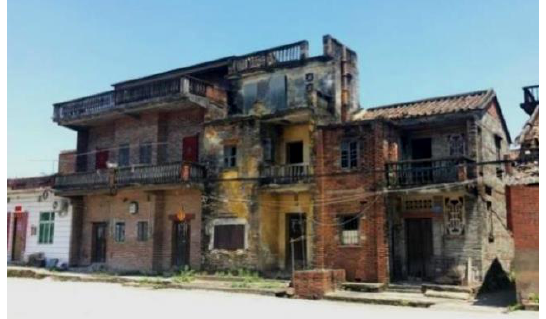
Figure 6. Spatial interface of Xiantang Village, Guangzhou City (source: the authors).